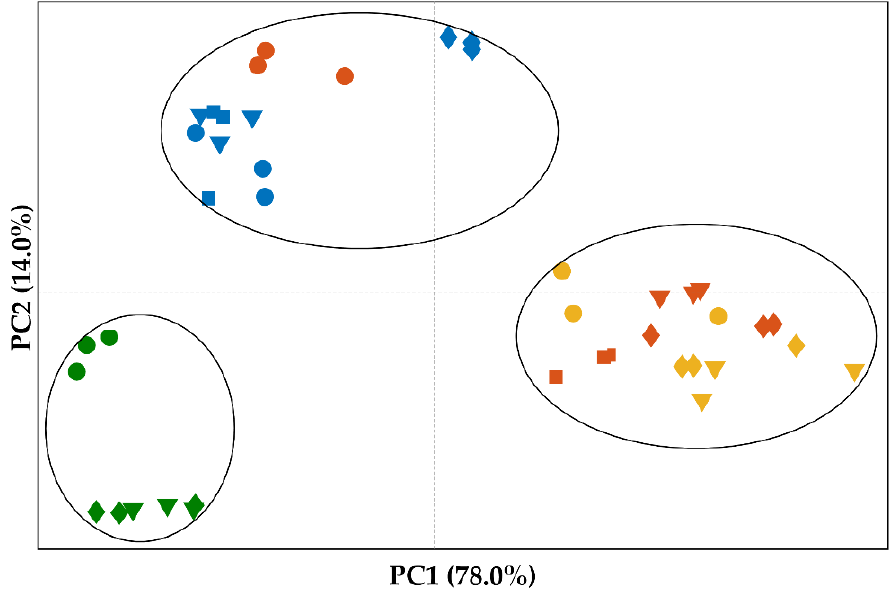
Figure 6. Scores plot from the principal component analysis conducted on the FTIR spectra of samples prepared using the placebo-based formulation (Formulation P, green), formulation I (blue) or formulation II, using the crystalline (orange) or the co-amorphous (yellow) form of olanzapine and saccharin, as starting material. Markers reflect the nature of samples: physical mixtures (circles), extrudates (diamonds), uncoated pellets (triangles), or pellets coated with olanzapine or olanzapine and saccharin (squares).